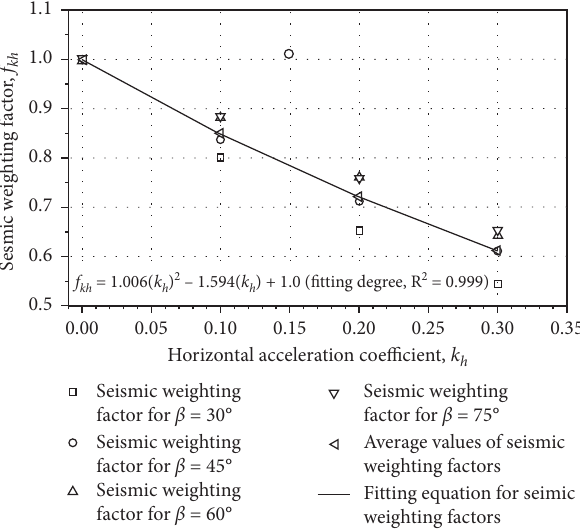
Figure 9: The chart for seismic weighting factor.